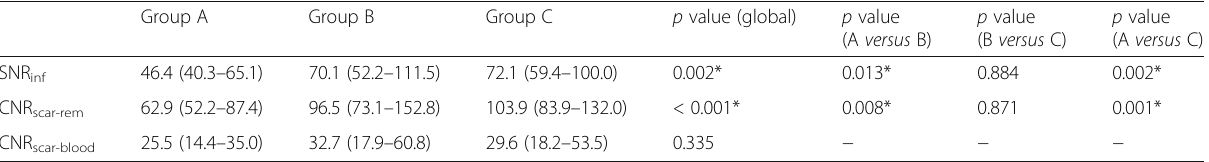
Table 2 Image quality and differences among the three groups according to the dose of gadobutrol used for late gadolinium enhancement Group A Group B